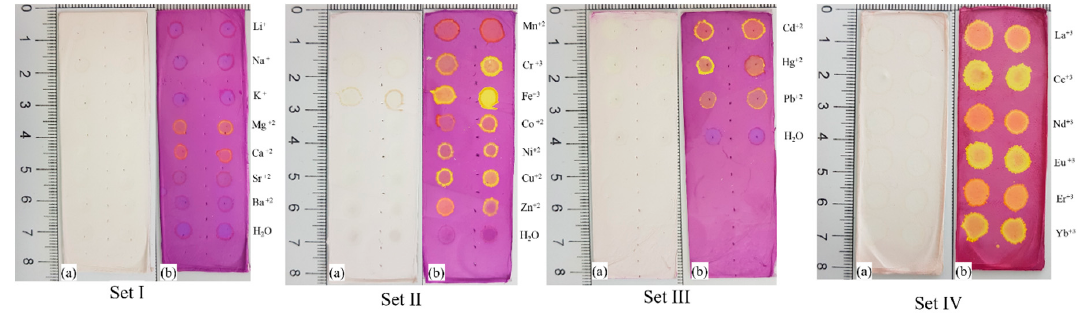
Figure 6. Photographs the photochromic nanofibers after 2 µL metals aqueous solution spots for set I, II, III, and IV. Metal ions spots after (a) visible light irradiation and (b) after UV light